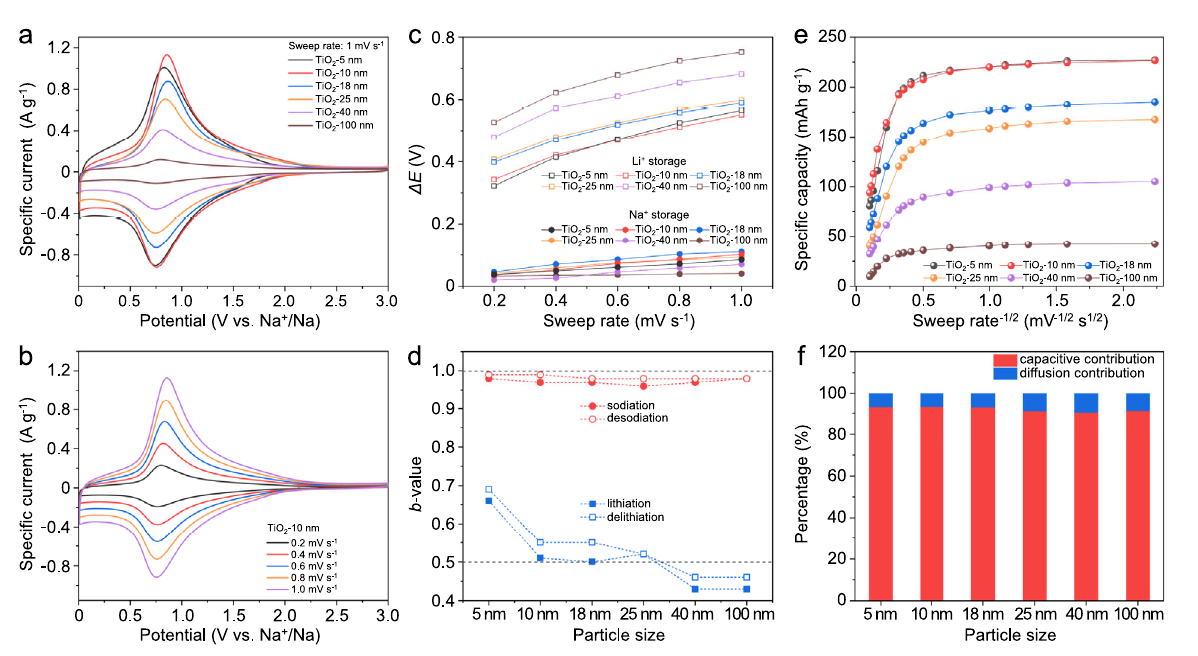
Fig. 4 | Charge storage properties of TiO 2 for lithium and sodium ions. a CV curves of the TiO 2 NPs at the sweep rate of 1.0mVs − 1 showing small voltage offset between redox peaks. b CV curves of TiO 2 -10nm at sweep rates of 0.2 – 1.0mVs − 1 , indicating slight peak shifts with increasing sweep rates. c The potential gap betweenthecathodicandanodicpeaks( Δ E )asafunctionofparticlesizeandsweep